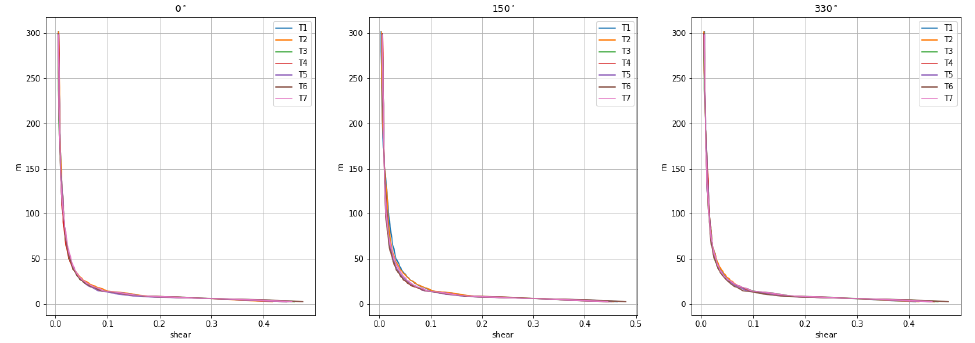
Figure 6. Wind speed profile for the 0 ◦ , 150 ◦ , and 330 ◦ direction sectors.